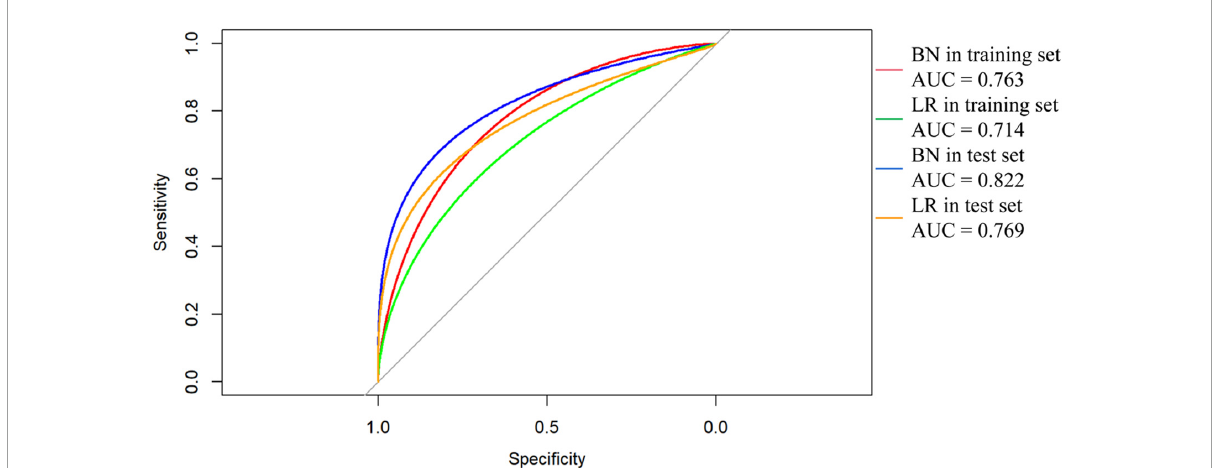
FIGURE3 Receiver operating characteristic (ROC) curves of Bayesian network (BN) model and logistic regression (LR) model for predicting ischemic stroke (IS) in patients with dilated cardiomyopathy (DCM). The areas under the curve (AUC) of BN model predicting IS was 0.763 (95% CI,